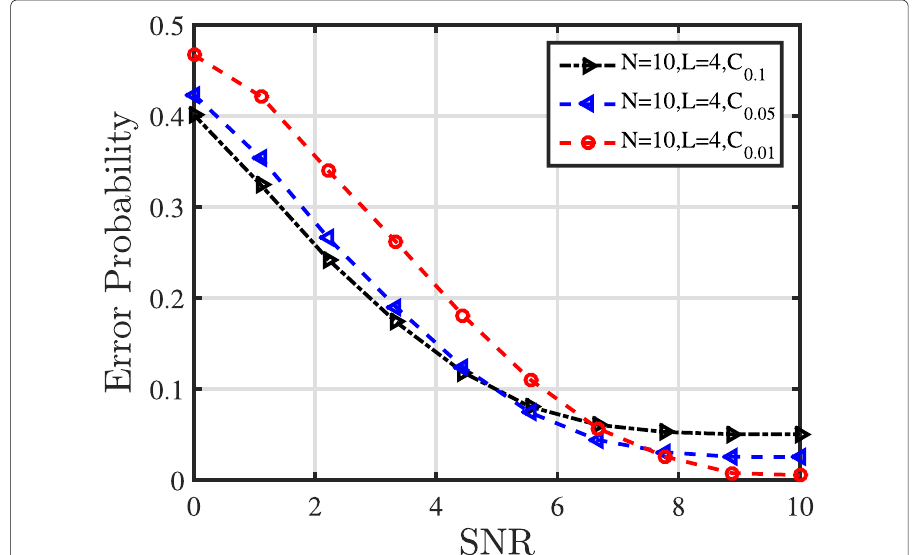
Fig. 6 Effect of error floor value on the classifier performance for C 0.01 , C 0.05 and C 0.1 for D 1 = {QPSK,8PSK}. Higher error floor values gain us in low-SNR value performance